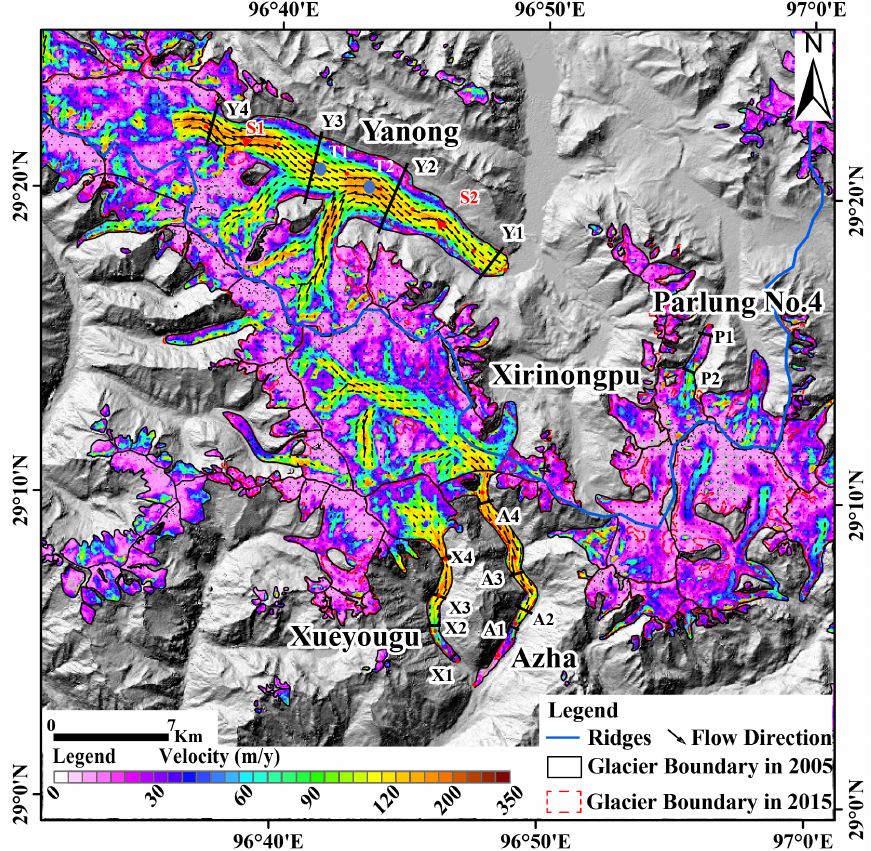
Figure 4. Mean annual glacier velocity in the Parlung Zangbo Basin during 2013–2020. The velocity maps overlay the gray-shade void-filled SRTM DEM. The blue lines are mountain ridges, and the black lines are glacier boundaries in 2005 (SCGI). The red dashed lines are glacier boundaries in 2015 [56]. The blue dots (T1, T2) are junction points of Yanong Glacier where tributary glaciers merge into the main trunk glacier. Red lines with dots in some glaciers show the flow centerline. The thick black lines across glaciers indicate the transects